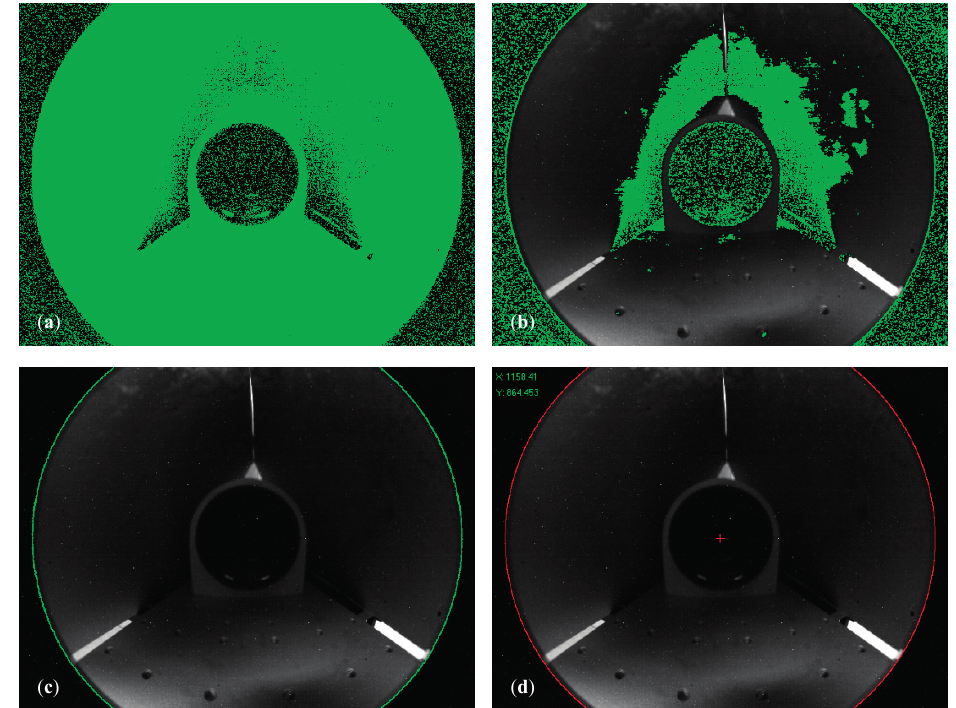
Figure 8. Image processing steps for the determination of the mirror position in the camera plane. ( a ) Threshold image; ( b ) Boundaries extracted from the threshold regions of high intensity; ( c ) Start image and corresponding fitting ellipse (in green); ( d ) Final results with the estimation of the center coordinates (red